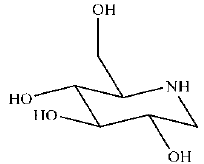
Figure 1. The chemical structure of 1-deoxynojirimycin.